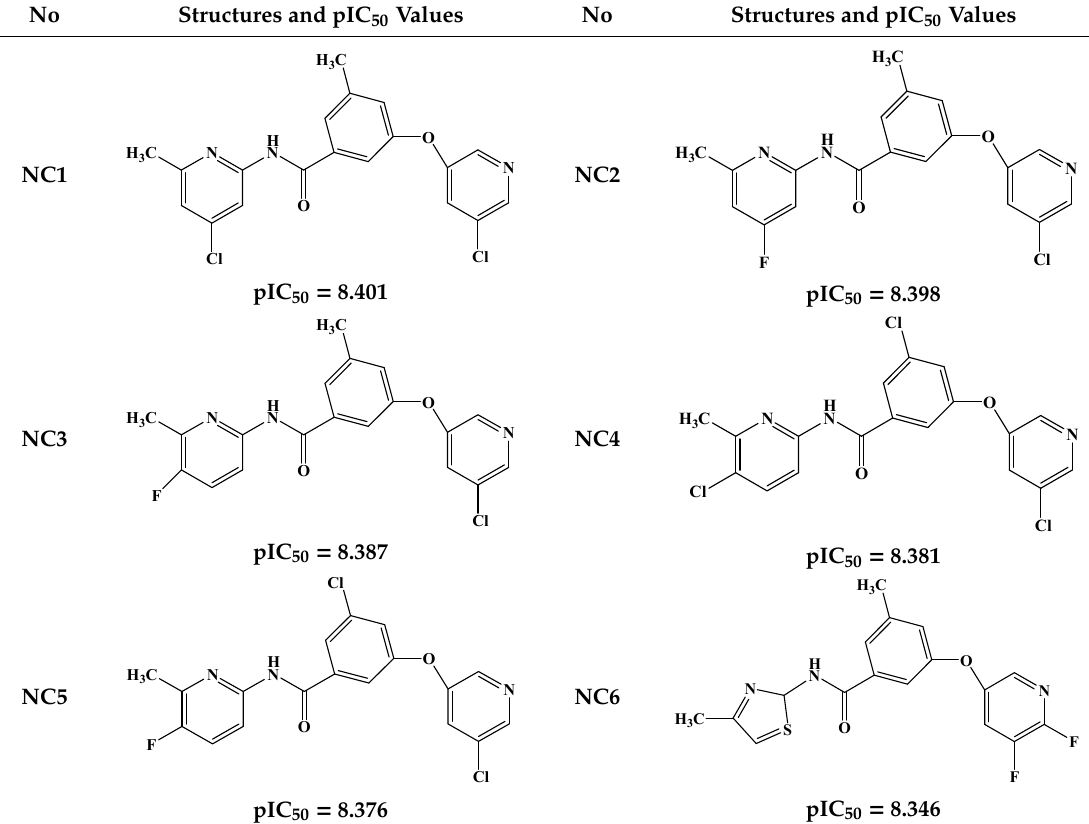
Table 5. Structures and predicted activities of newly designed mGluR5 NAMs.